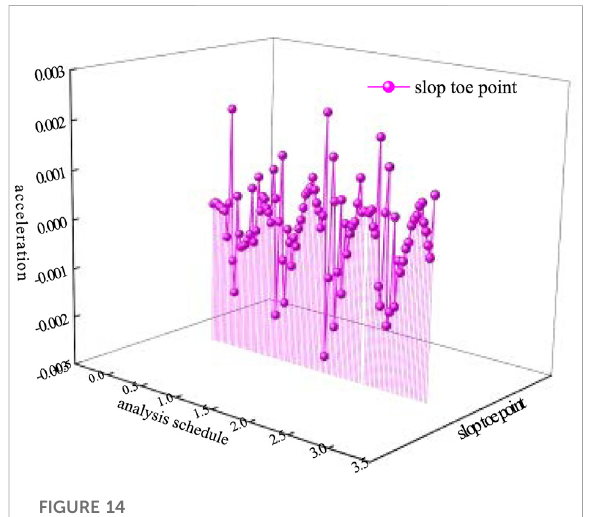
Vibration rule of vertical acceleration of roadbed slope point at